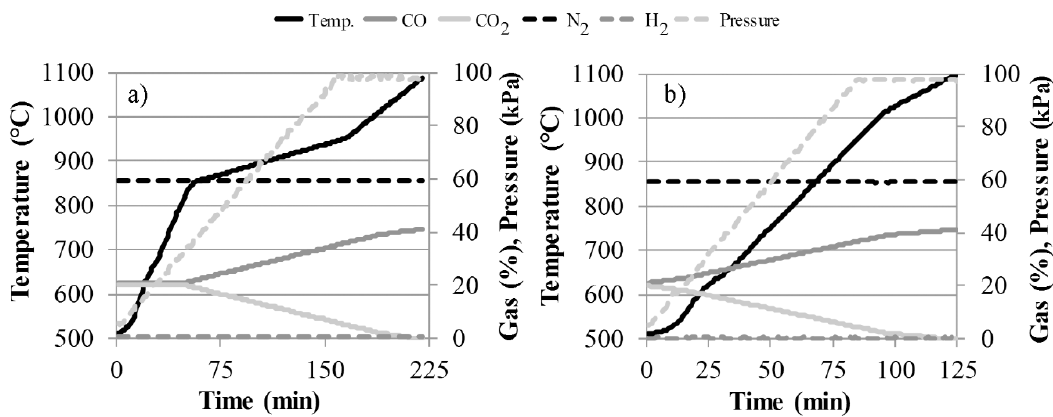
Figure 2. Heating profile, gas profile, and mechanical pressure during the ( a ) wall program and ( b ) center program of the laboratory-scale BF experiment.